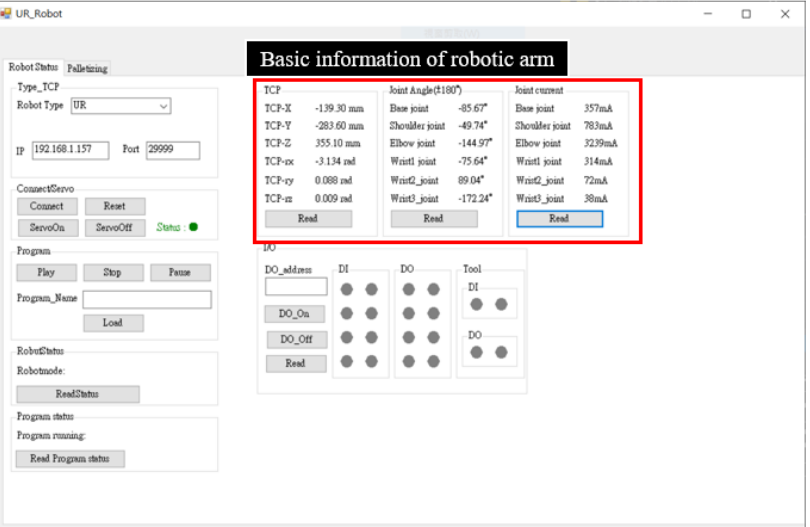
Figure 31. User interface of palletizing.